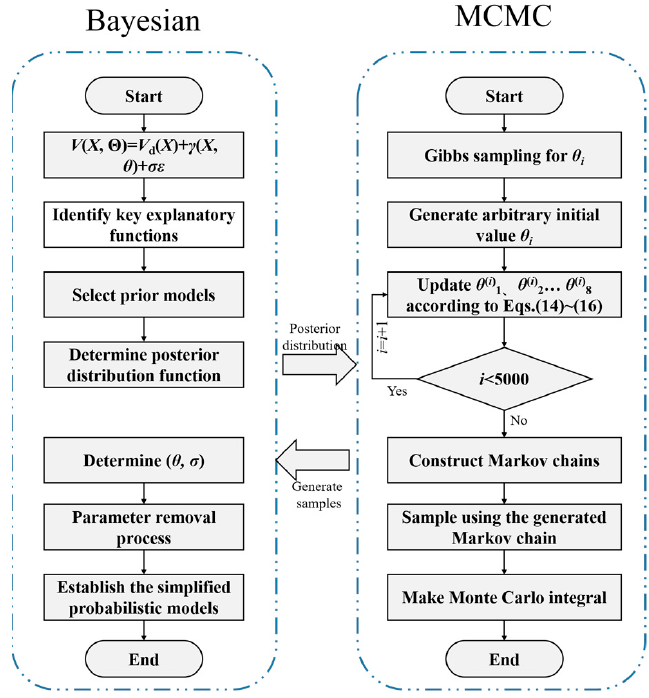
Figure 2. Flow chart of solution procedure for Bayesian–MCMC method. Table 2. Well-known shear strength